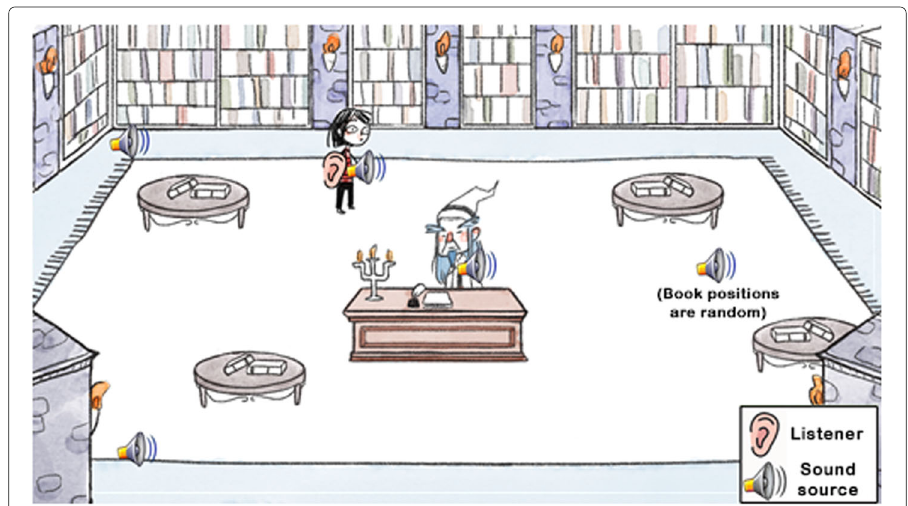
Fig. 4 Library stage with indication of the listener’s position and all the scenario sound sources